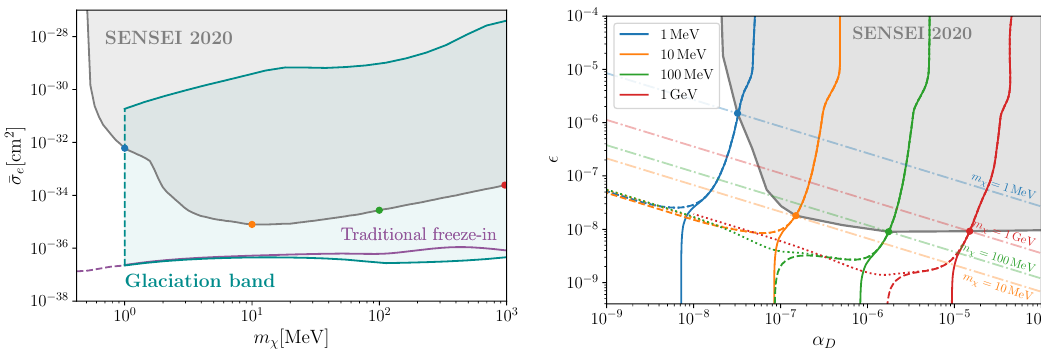
Figure 4 . Left : the glaciation band on the direct detection parameter space, showing that large regions of UV-insensitive parameter space have already been ruled out by SENSEI. Right : contours of Ω Ω = 1 in the α – (cid:15) plane for different values of DM masses (solid, dashed and dotted DM / Obs D lines are for different temperature ratios as in figure 2). The intersection of the contours with the direct detection constraints on (cid:15) 2 α (dash-dotted lines) illustrates the construction of the exclusion D